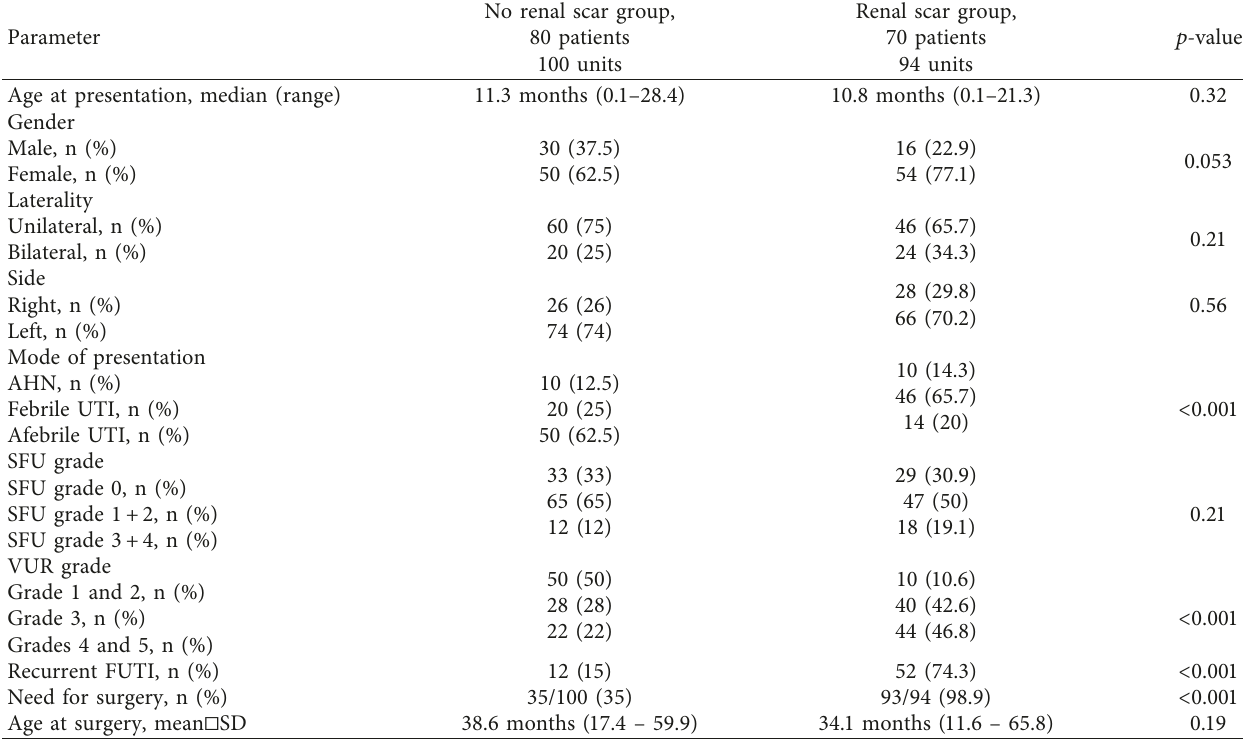
Table 1: Patients’